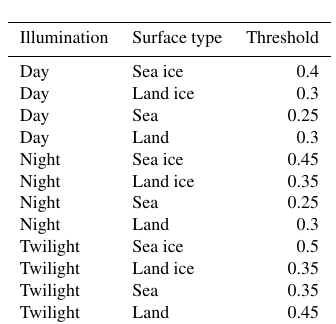
Table B2. Empirical thresholds used to convert the output of the cloud mask ANNs into a binary cloud mask. Thresholds depend on illumination conditions and surface type.